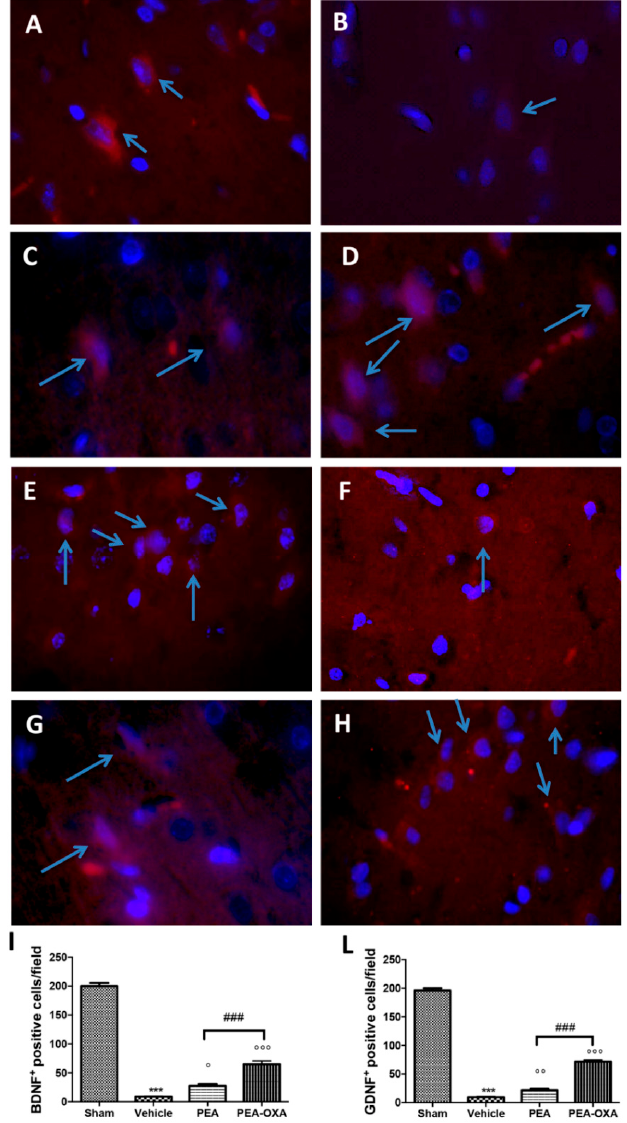
Figure 8. Efficacy of PEA-OXA on BDNF and GDNF expression (induced by transient MCAo). The immunofluorescence of brain samples showed that PEA-OXA-administered animals exhibited the presence of an increased number of positive cells for BDNF ( D , I ) and GDNF ( H , L ) staining compared to the samples from vehicle-treated rats ( B , I ; F , L ). PEA displayed less protection ( C , I ; G , L ). Sham-operated animals showed basal levels of BDNF ( A , I ) and GDNF ( E , L ). The number of BDNF- and GDNF-positive cells was counted in three sections per animal and is presented as the number of positive cells per high-power field. For immunofluorescence, a 100× magnification is shown (10-µm scale bar). A p -value of less than 0.05 was considered significant: * p < 0.05 versus sham; ° p < 0.05 versus vehicle; ** p < 0.01 versus sham; °° p < 0.01 versus vehicle; *** p < 0.001 versus sham; °°° p < 0.001 versus vehicle; # p < 0.05 versus PEA; ## p < 0.01 versus PEA; ### p < 0.001 versus PEA